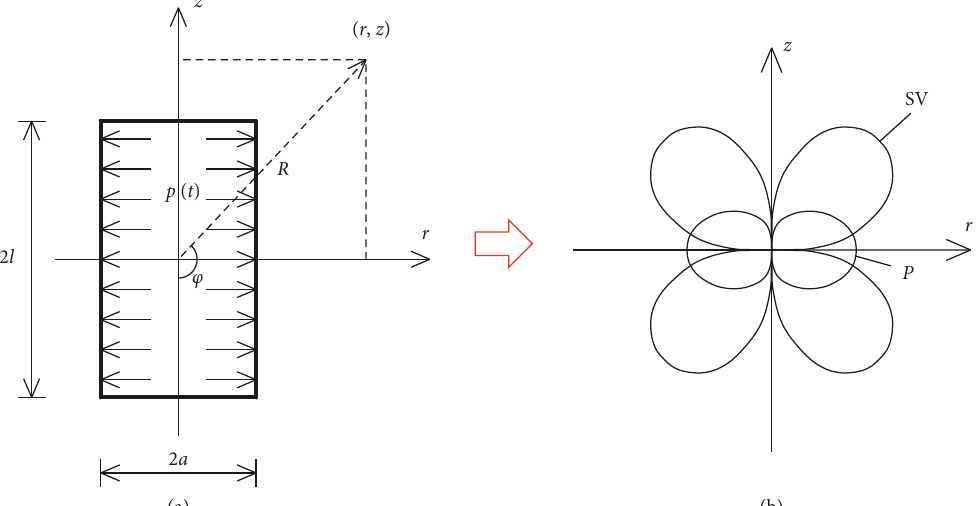
Figure 5: Illustration of the Heelan radiation. (a) Simplified mechanical model of a short column explosive. (b) Seismic radiation from a short column